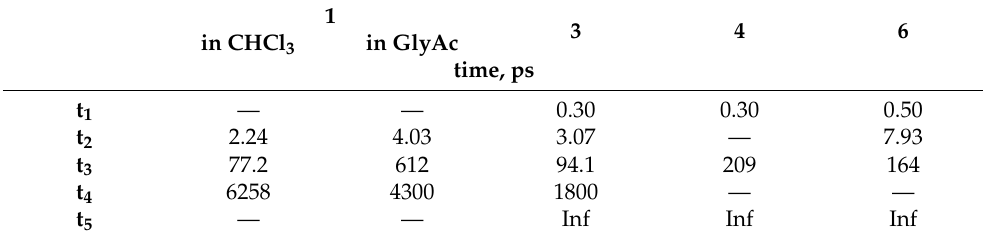
Figure 11. fsTA map (panel A ), spectra at certain time delays (panel B ), and decay-associated spectra (panel C ) of 1 , 3, 4 and 6 . Table 3. Global lifetime analysis of 1 , 3 , 4 and 6